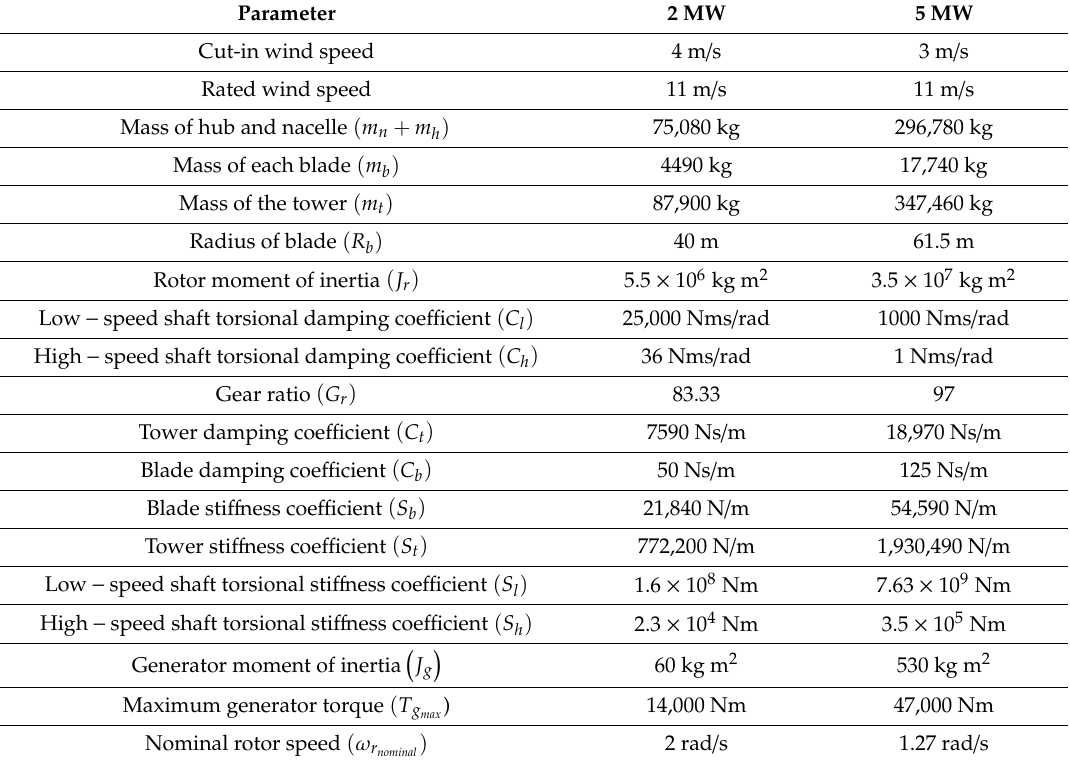
Table 2. Wind turbine